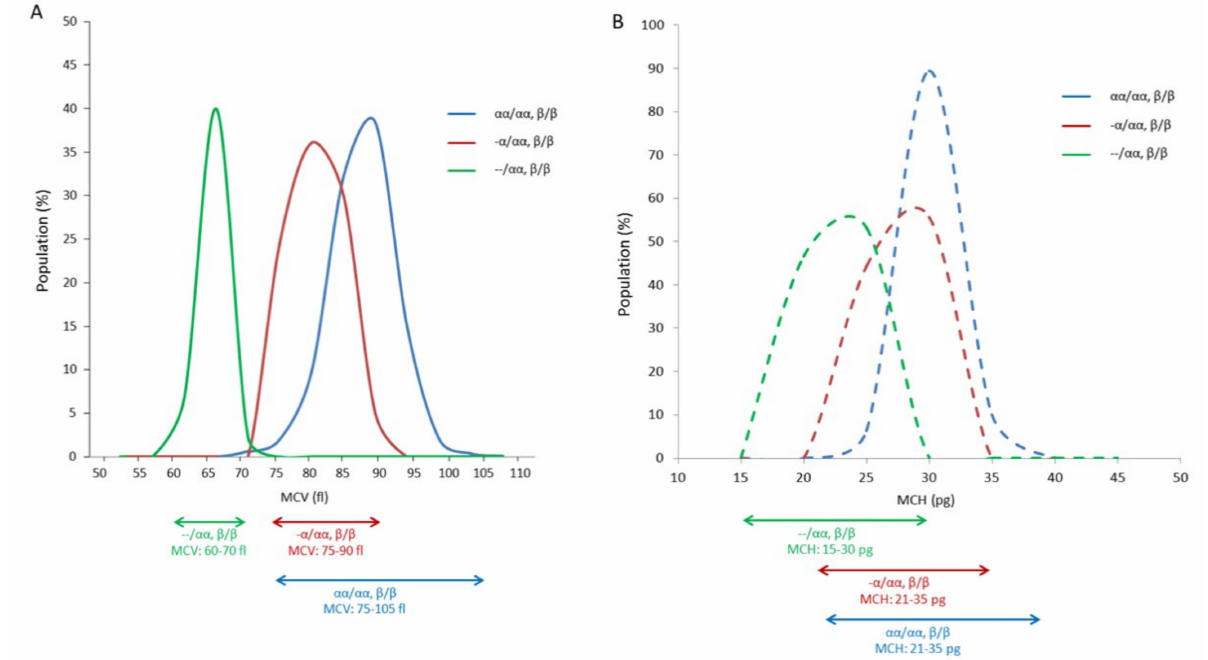
Figure 1. Ranges of RBC index parameters: MCV ( A ) and MCH ( B ) among the population of normal globin gene ( αα / αα , β / β ), α + -thal (- α / αα , β / β ), and α o -thal (–/ αα , β / β ).